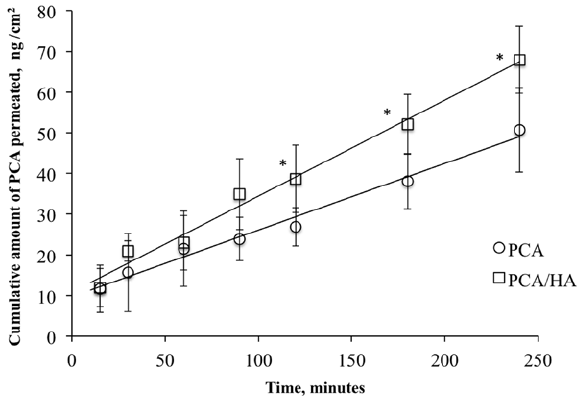
Figure 1. Permeation profile of 5-oxo-2-pyrrolidinecarboxylic acid (PCA) across isolated rabbit corneas for PCA ( ○ ) and PCA/HA mixture ( □ ). Means ± SD; n = 6. * Statistically significant different, ( p < 0.05, t -test).